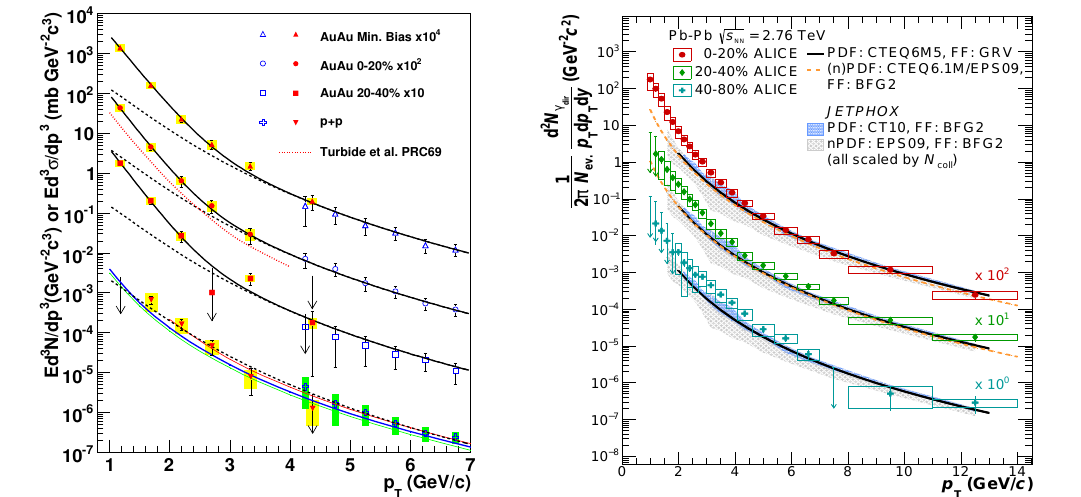
Figure 26. Left : The invariant cross-section ( p + p ) and invariant yield (Au + Au) of direct photons as functions of p T . The three curves on the p + p data represent the NLO pQCD calculations, and the dashed curves show a modified power-law fit to the p + p data, scaled by T AA = (cid:104) N coll (cid:105) / σ in . NN The dashed ( black ) curves are the same, but with the exponential plus scaled p + p data. The dotted (red) curve near the 0%–20% centrality data is a theory calculation. Reproduced from Ref. [356]; Right : √ s The direct photon spectra in Pb + Pb collisions at = 2.76 TeV for the 0%–20% (scaled by a factor NN of 100), the 20%–40% (scaled by a factor of 10), and the 40%–80% centrality classes compared to the NLO pQCD predictions for the direct photon yield in pp collisions at the same energy, scaled by a number of binary nucleon collisions for each centrality class. Reproduced from Ref.